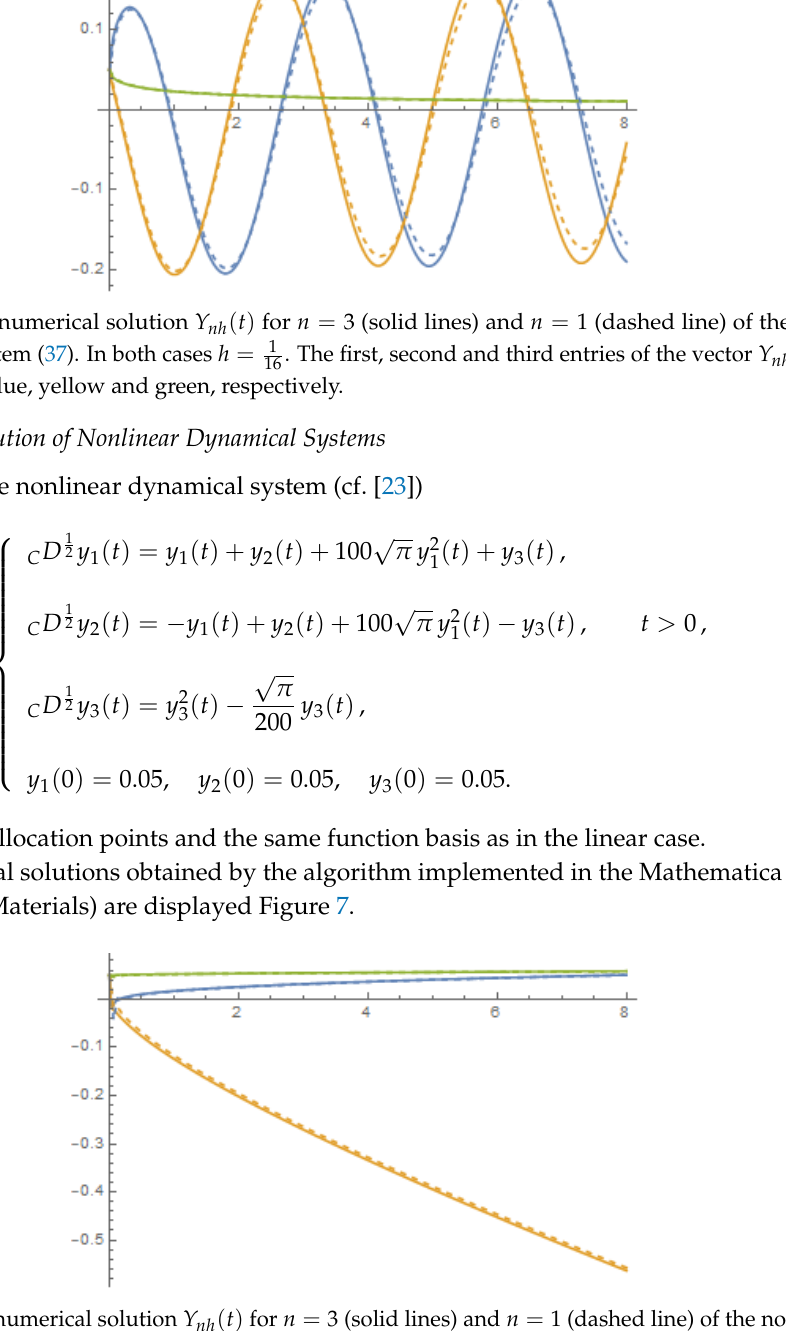
Figure 7. The numerical solution Y nh ( t ) for n = 3 (solid lines) and n = 1 (dashed line) of the nonlinear dynamical system (38). In both cases h = 1 . The first, second and third entries of the vector Y nh ( t ) are 16 displayed in blue, yellow and green,